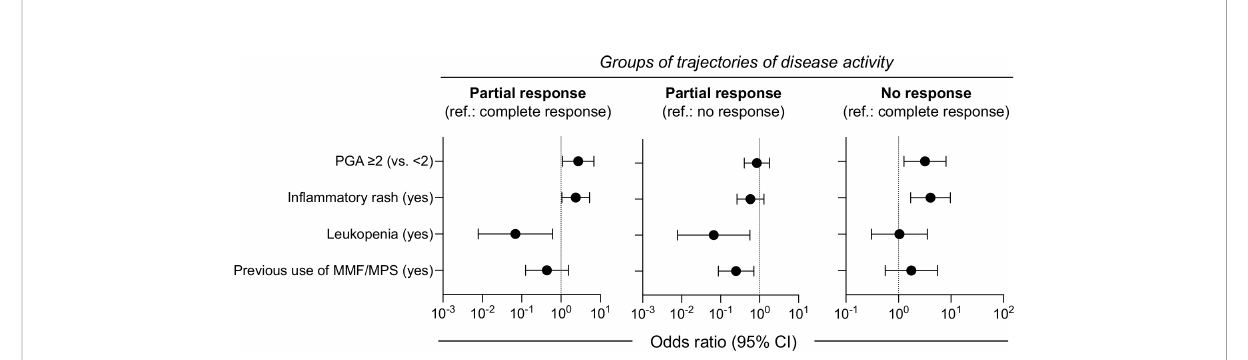
FIGURE 3 Baseline factors may predict clinical response trajectories in belimumab-treated SLE patients. Multinomial regression analysis was performed to identify baseline clinical parameters associated with the trajectory-based groups of response to belimumab. Patients with baseline PGA ≥ 2.0 or in fl ammatory rash were more likely to belong to the partial response (PR) (odds ratio [OR] 2.74; 95% con fi dence interval [95% CI] 1.09 – 6.85 and OR 2.37; 95% CI 1.05 – 5.35, respectively) and the non-response (NR) (OR 3.19; 95% CI 1.27 – 8.06 and OR 4.07; 95% CI 1.70 – 9.71, respectively) than the complete response (CR) group. Leukopenia was linked to reduced risk for PR as compared to CR (OR 0.07; 95% CI 0.01 – 0.61) and NR (OR 0.07; 95% CI 0.01 – 0.56). Prior use of mycophenolate was associated with lower risk for PR versus NR (OR 0.25; 95% CI 0.09 –